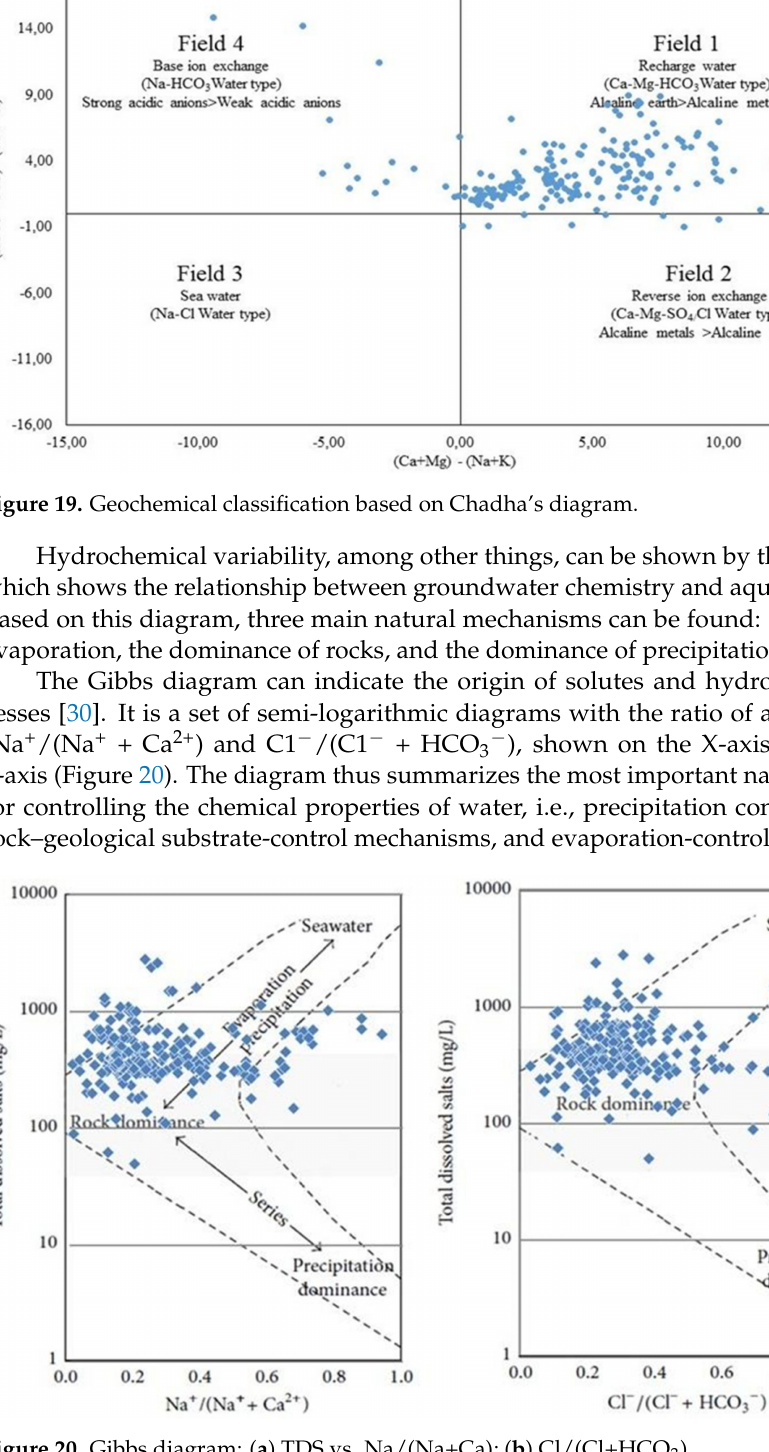
Figure 20. Gibbs diagram: ( a ) TDS vs. Na/(Na+Ca); ( b ) Cl/(Cl+HCO 3